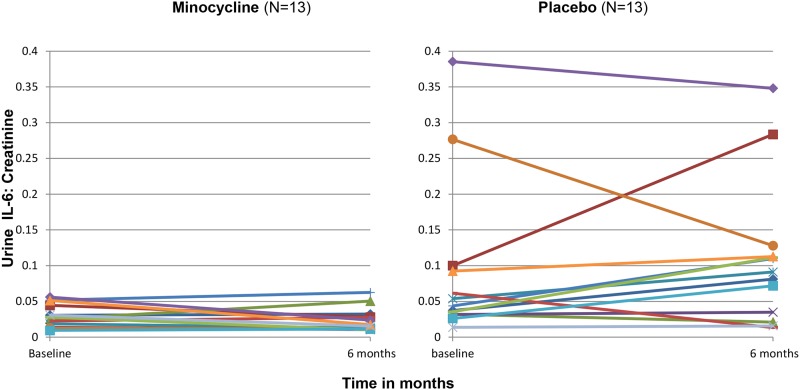
Spaghetti plots of the urine IL6: creatinine measurements of each patient in the study from baseline to 6 months (end of trial).Baseline urine values were not available for 3 subjects.